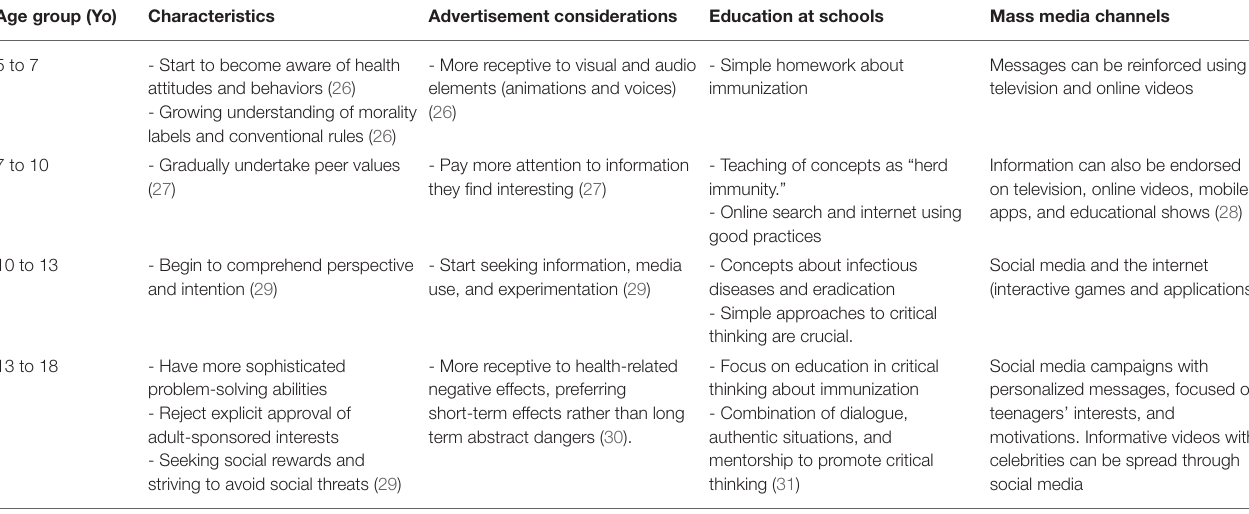
TABLE 1 | Characteristics, advertisement considerations, and preferred communication tools for children and adolescents per age group. Age group